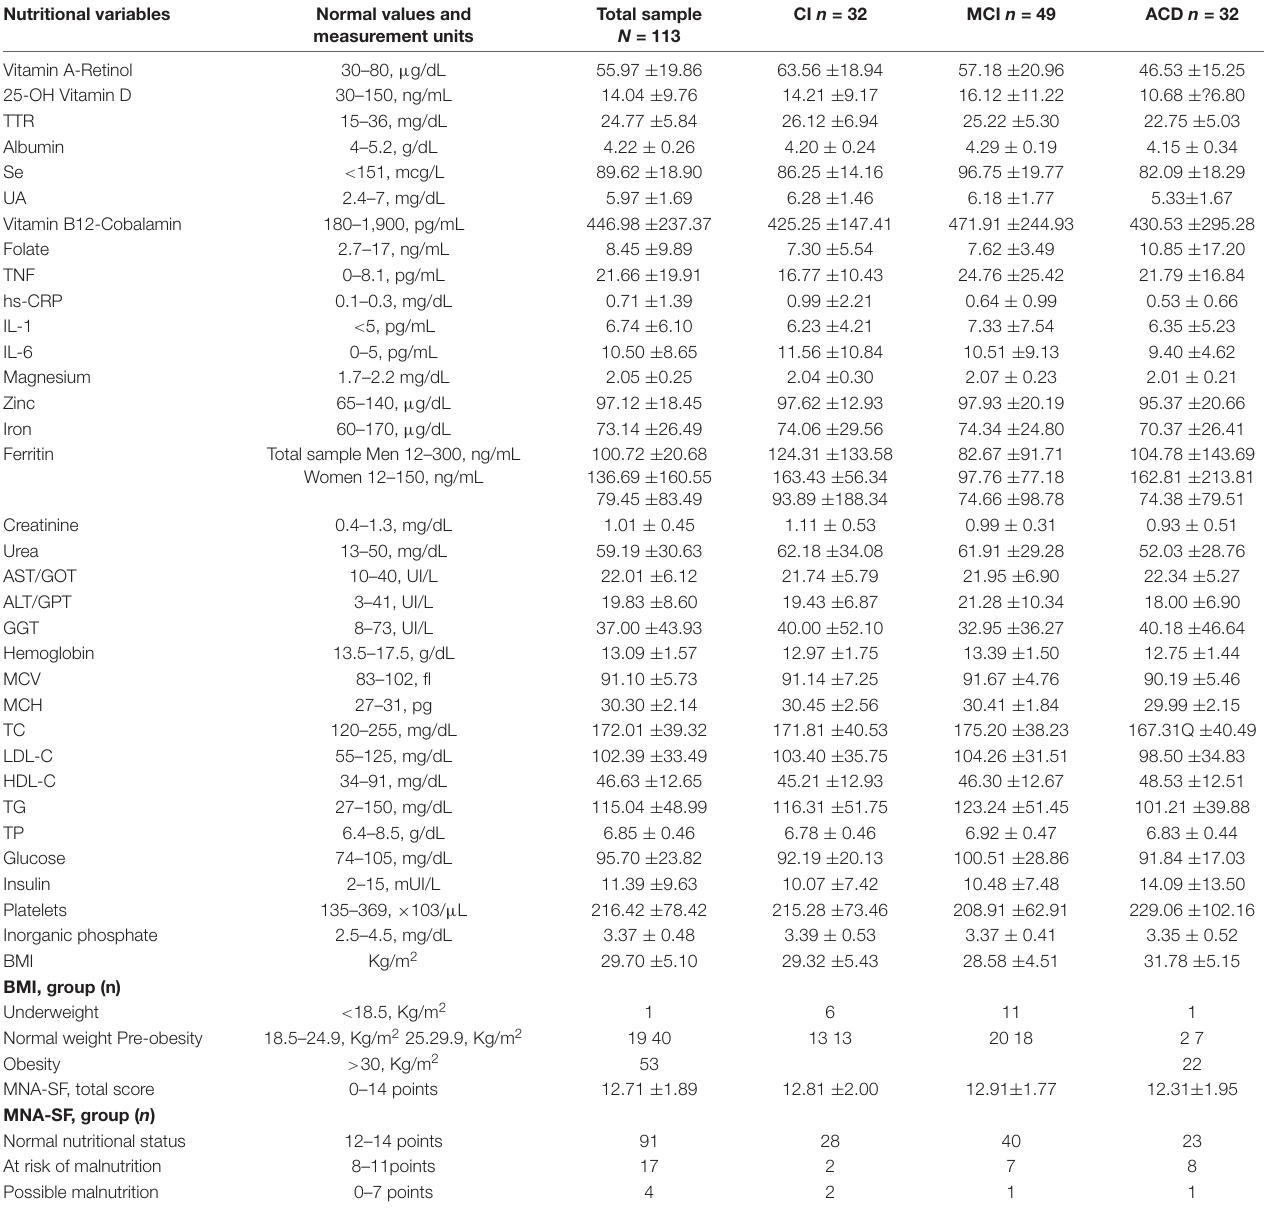
TABLE 3 | Descriptive statistics ( M ± SD ) for blood biomarkers, BMI, and MNA-SF scores. Nutritional